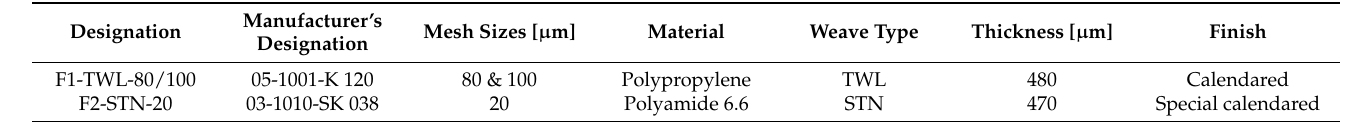
Table 1. Applied filter cloth types with their distinct properties and